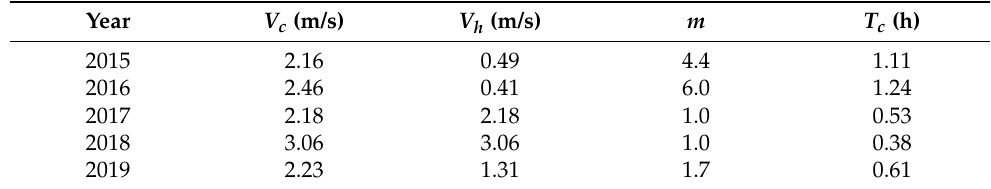
Table 3. Comparison of channel velocity ( V c ), hillslope velocity ( V h ), their ratio m , and concentration time ( T c ) estimated for each rainfall-runoff event.